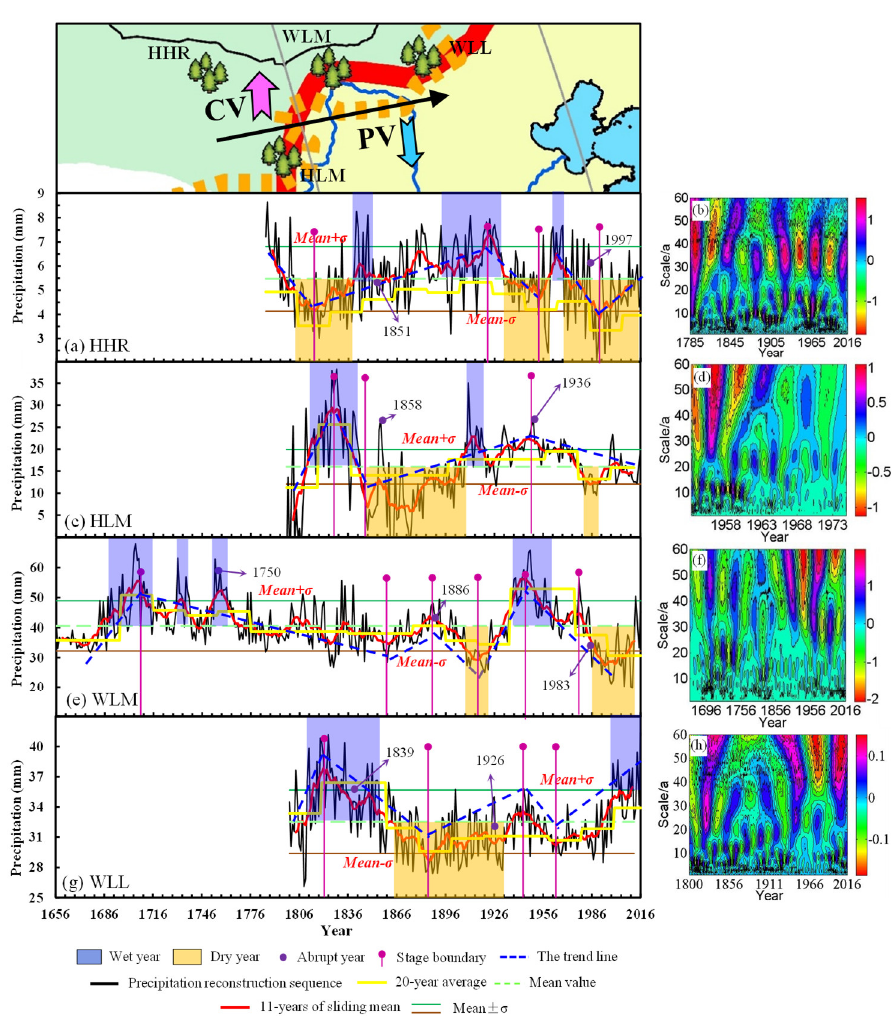
Figure 7. ( a , c , e , g ) Variations in the reconstructed precipitation series during the growth season (March to August). ( b , d , f , h ) Wavelet analysis time-frequency distribution of the reconstructed se-